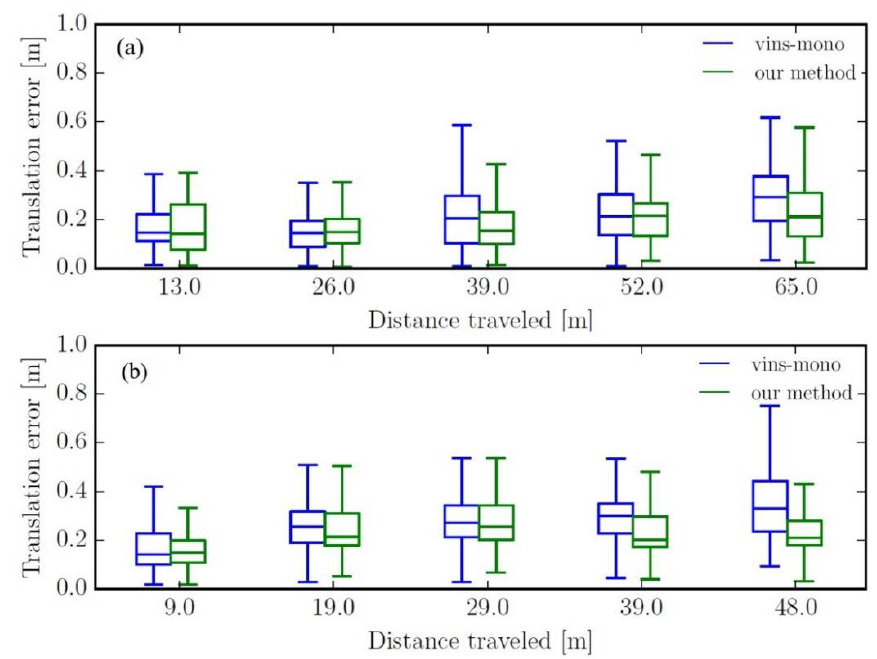
Figure 6. Translation error plot: ( a ) MH_03_median, ( b ) MH_05_median.